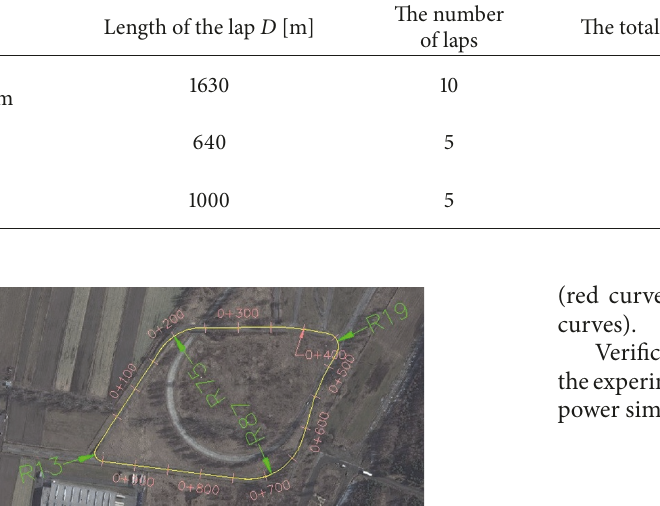
Figure 14: Plan view of the path of the drive on route 3 in Tychy.